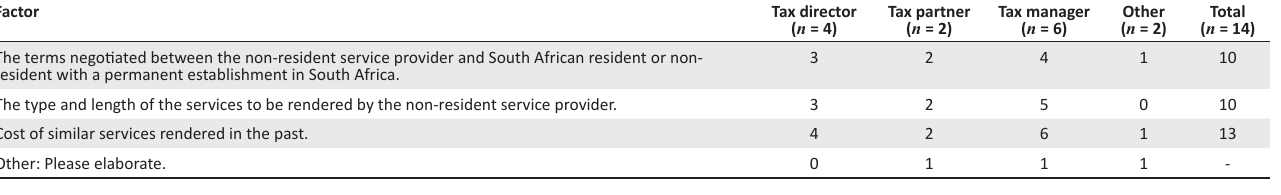
TABLE 9: Results of the contributing factors that help in determining the total anticipated service expense.